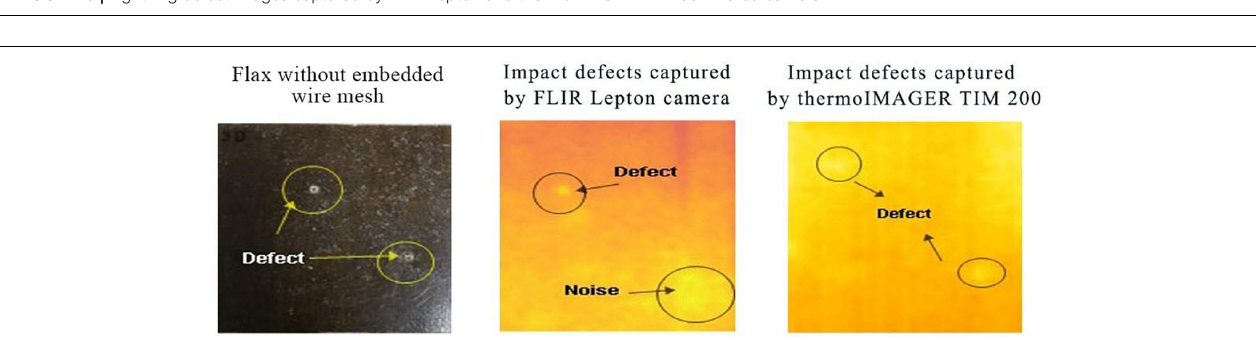
FIGURE 8 | Lightning defect images captured by FLIR Lepton and thermoIMAGER TIM200 infrared camera.